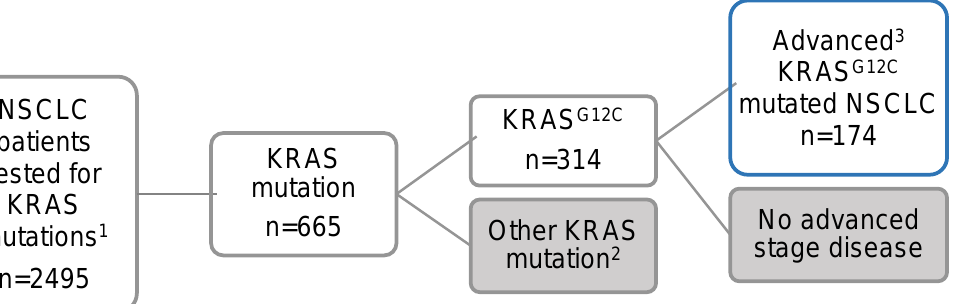
Figure 1. The study population. 1 Patients were tested between January 2017 and October 2021.